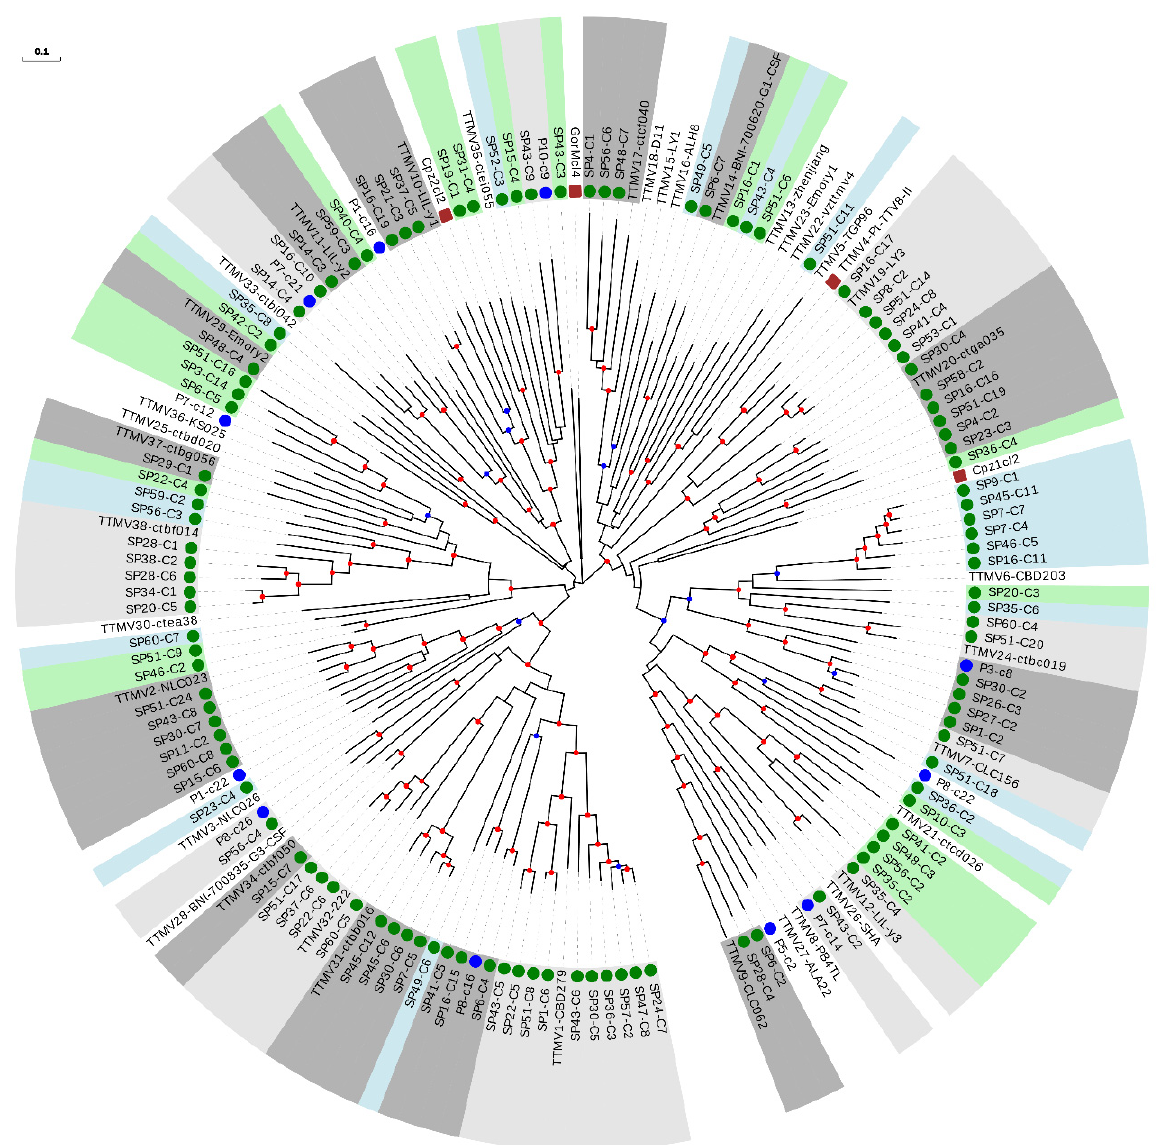
Figure 3. Phylogenetic tree of ORF1 sequences from the TTMV genus. Sequences described in this study are marked with a green circle. Sequences identified as new species after reevaluating data from our previous study [18] are marked with a blue circle. New species (including one or more new sequences) are indicated with background green or blue color in order to distinguish contiguous clusters. Clusters of representative species including new sequences are indicated with background light or dark grey colors in order to distinguish contiguous clusters. Non-hominid primate isolates are marked with a brown square. Nodes supported by bootstrap values ranging 0.7–0.85 and 0.85–1.0 are indicated with blue and red circles, respectively. The scale bar indicates the evolutionary distance in nucleotide substitutions per site.